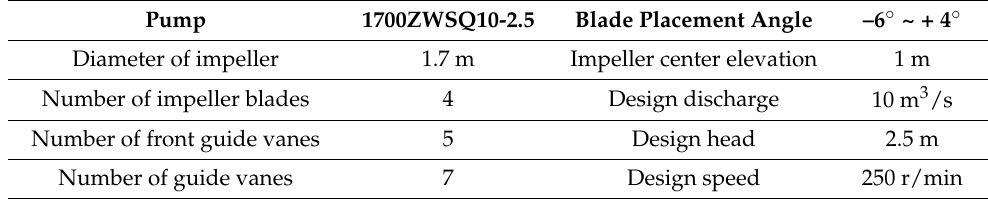
Table 1. Parameters of axial flow pump.